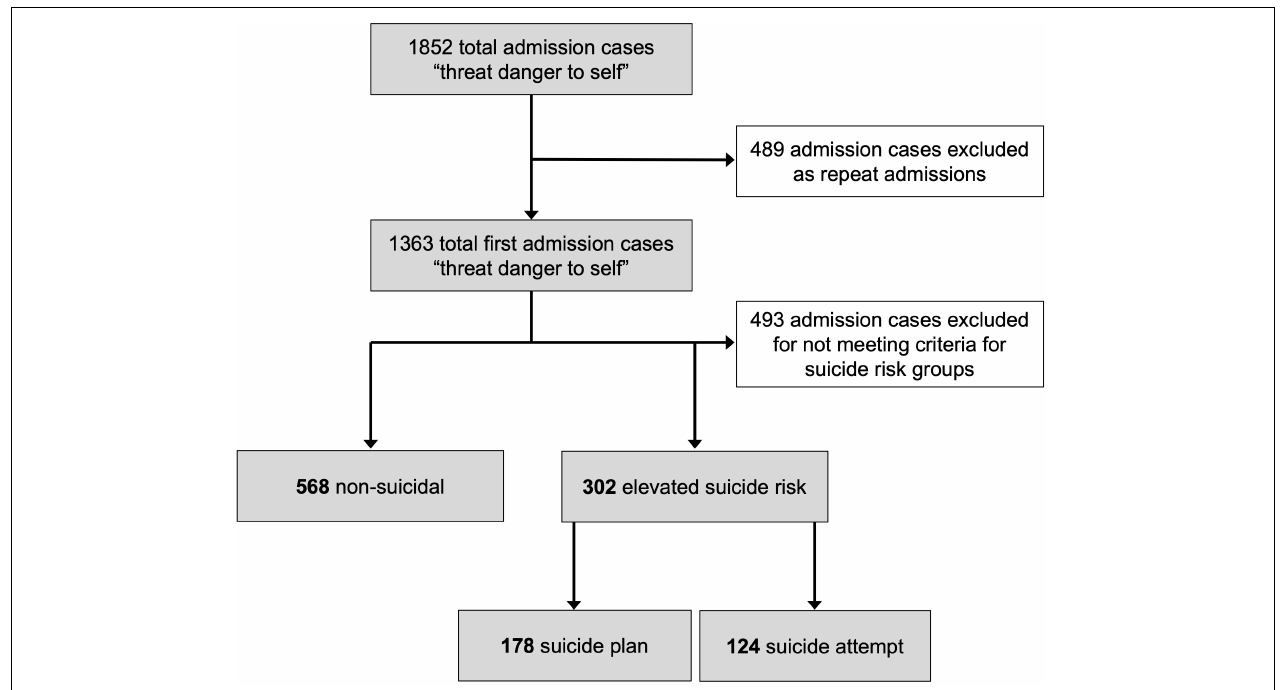
FIGURE 1 | A flow diagram depicting the sample criteria and